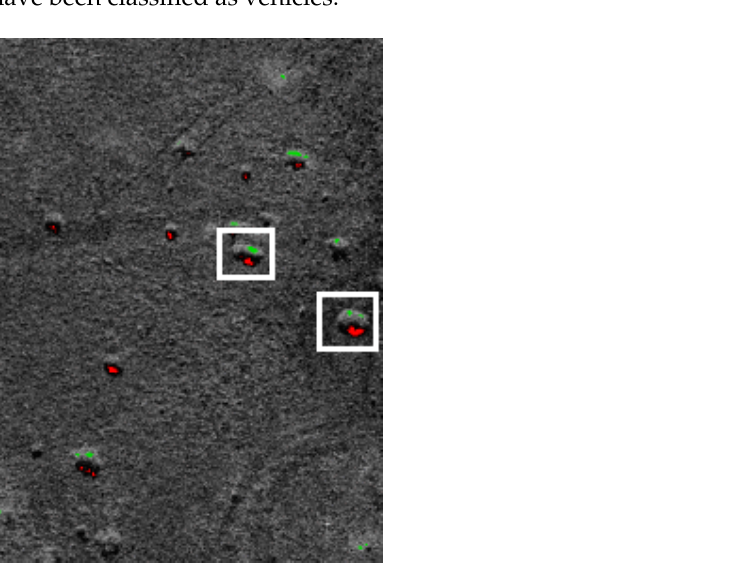
Figure 10. The image of the desert: stones recognized as